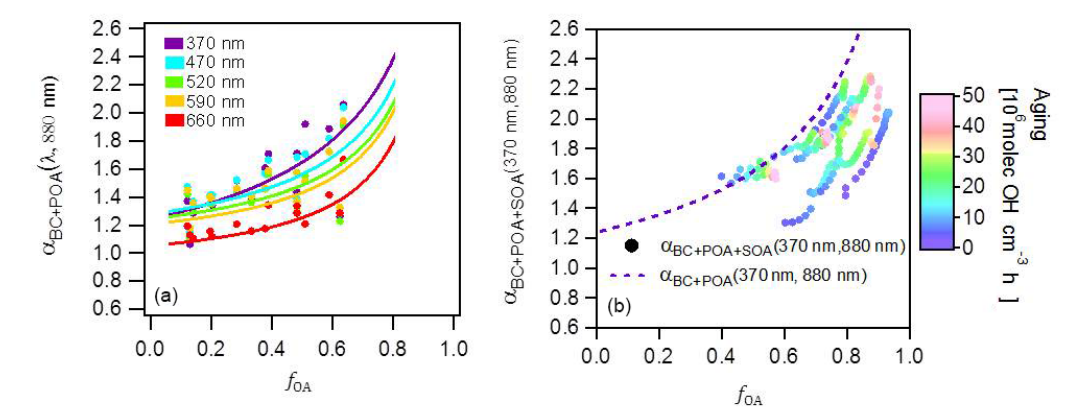
Figure 3. (a) Relationship of α BC + POA ( λ , 880nm) to f OA for seven wavelengths for primary emissions. Data are colored by the wavelength. Curves are fits of Eq. (13) to the data. Each point represents the average of one experiment and therefore the variability in f OA is related to the variability in the emission composition between experiments. (b) Relationship of α BC + POA + SOA (370, 880nm) to f OA for several experiments for aged aerosols. Data are color coded by the OH exposure. The variability in f OA is due to SOA formation with aging; data from several experiments are shown, which explains the wide range of f OA at low OH exposures. Note that more data are included in (a) than (b) , as primary emissions for some experiments were not aged.